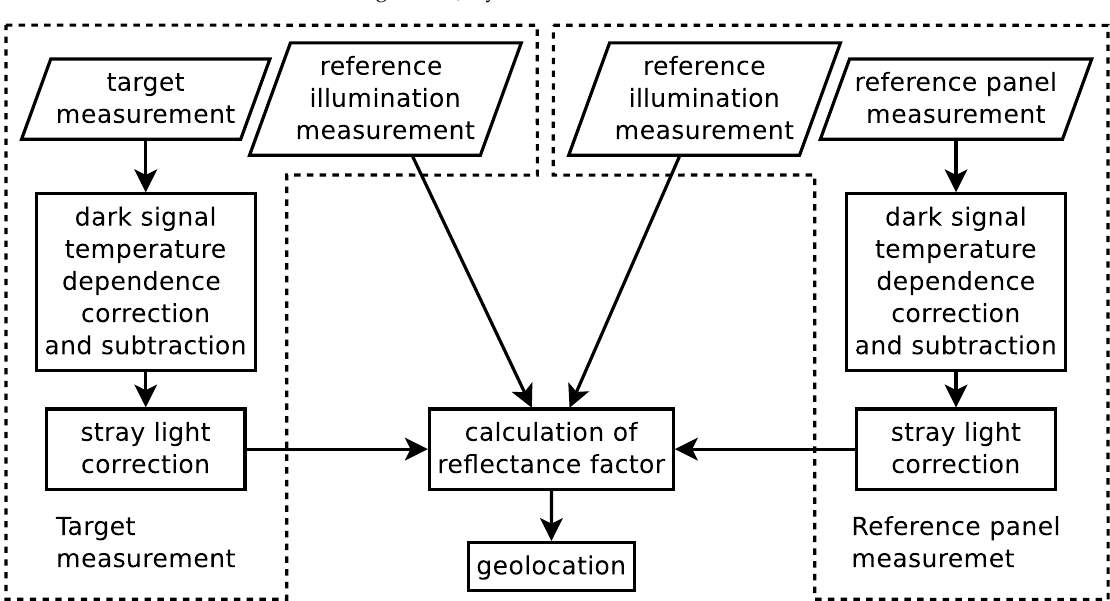
Figure 1. Flight route of helicopter measurements and forest stand borders. The background is the CHRIS scene DD40 band 12 image of 27 July 2011.